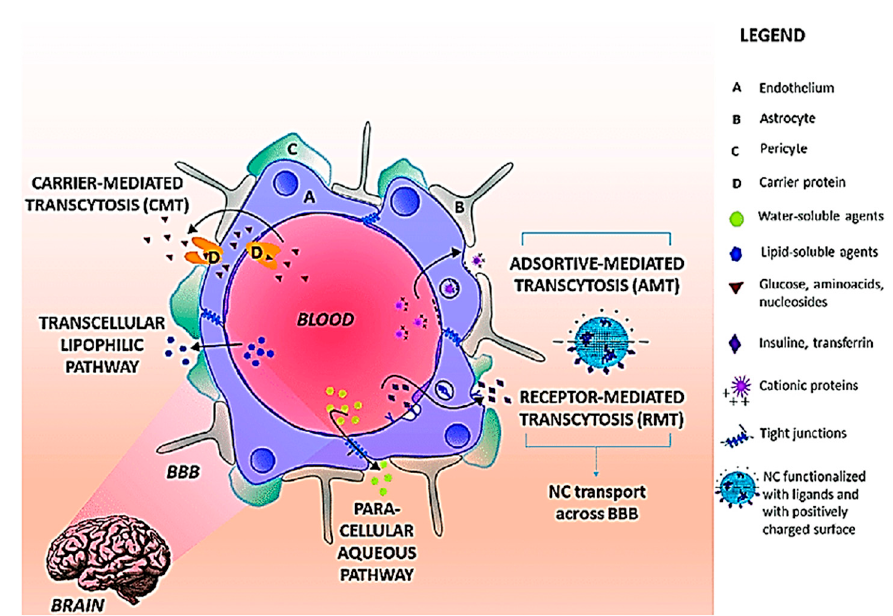
Figure 7. Transport pathways across BBB. The main routes for molecular traffic across the BBB are shown as well as the type of solutes that use each pathway. NC preferential pathways are (i) RMT when the NC surface is functionalized with ligands recognized BBB receptors and (iii) AMT when the NC surface is positively charged. Abbreviations: BBB: Blood Brain Barrier; NC: Nanocarriers; RMT: receptor mediated transcytosis; AMT: adsorptive-mediated transcytosis. Reproduced from [111], with permission from Elsevier, 2018.